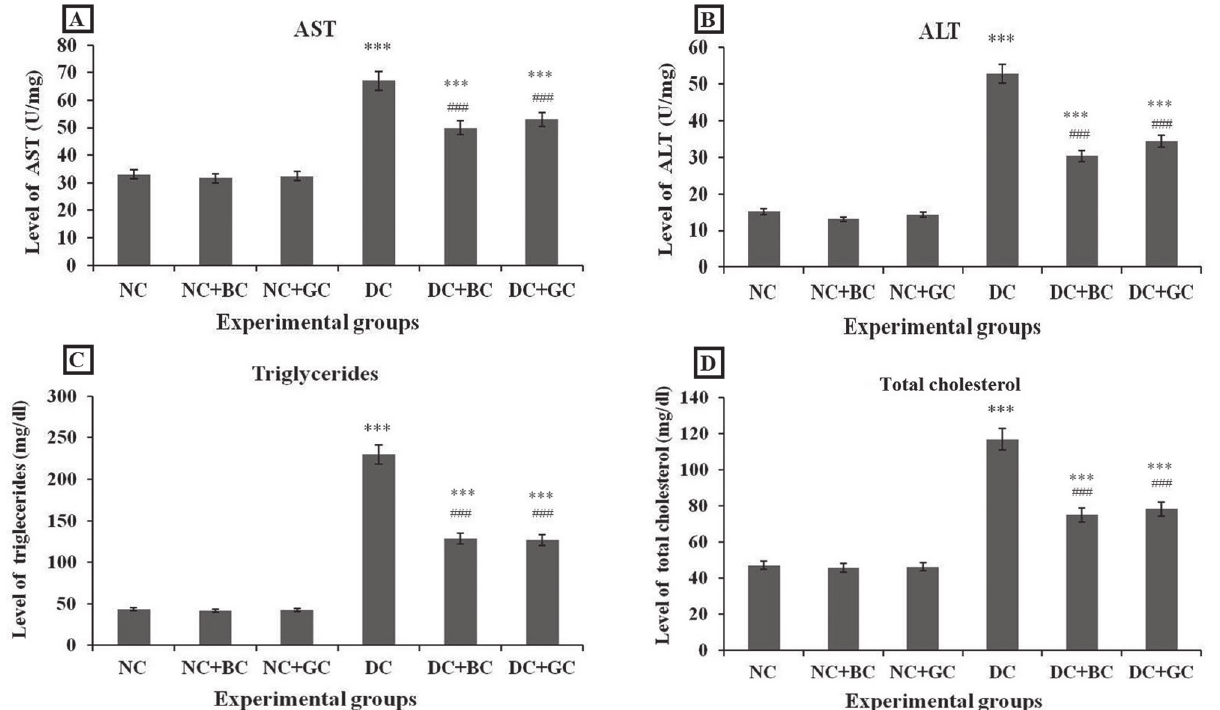
FIGURE 2 (A-D) - Effect of baicalein supplementation on AST, ALT, Triglycerides and Total cholesterol in different experimental groups. Data were expressed as mean ± SD and analyzed using one-way ANOVA followed by Tukey’s Multiple Comparisons Tests. Values are statistically significant at P < 0.05; **P < 0.05; ***P < 0.01 when compared with control group and ## P < 0.05; ### P < 0.01 when compared with diabetic group. NC: normal control, NC+BC: normal control treated with baicalein, NC+GC: normal control treated with glibenclamide, DC: diabetic control, DC+BC: diabetic rats treated with baicalein, DC+GC: diabetic rats treated with